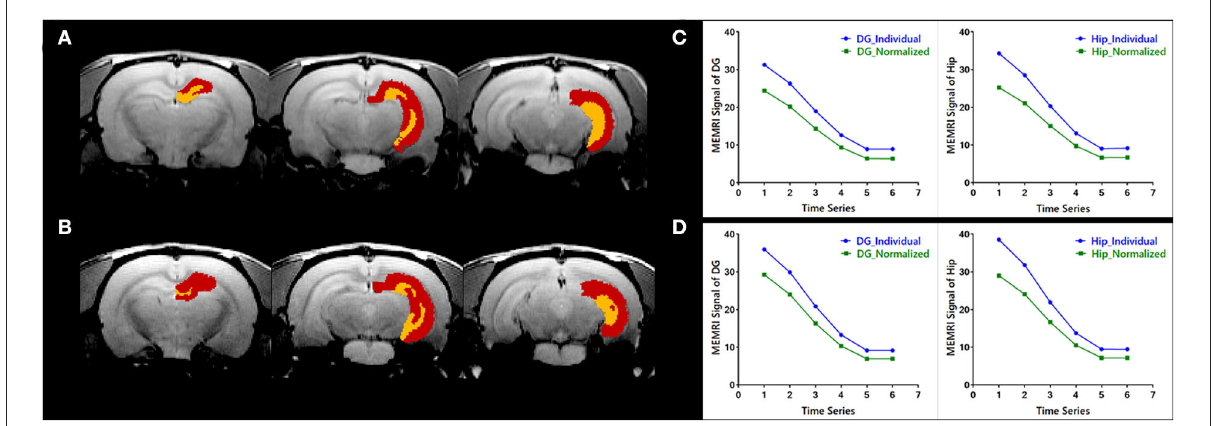
FIGURE3 Quantitative evaluation of the individual parcellations of MEMRI images of (A,C) a modal rat and (B,D) a healthy rat. The individual parcellations were shown in color scaled in which the right dentate gyrus was yellow and the right hippocampus was red. The MEMRI images were shown in gray scaled as background. Based on the individual parcellations, the mean MEMRI signal in each ROI was extracted and the curve is shown in blue color (C,D) . As a comparison, the MEMRI images of these two rats were also standardized into Paxinos space, and the mean signal in each ROI was then extracted based on the atlas in Paxinos space. The signal curve extracted in traditional way was shown in green color (C,D) .